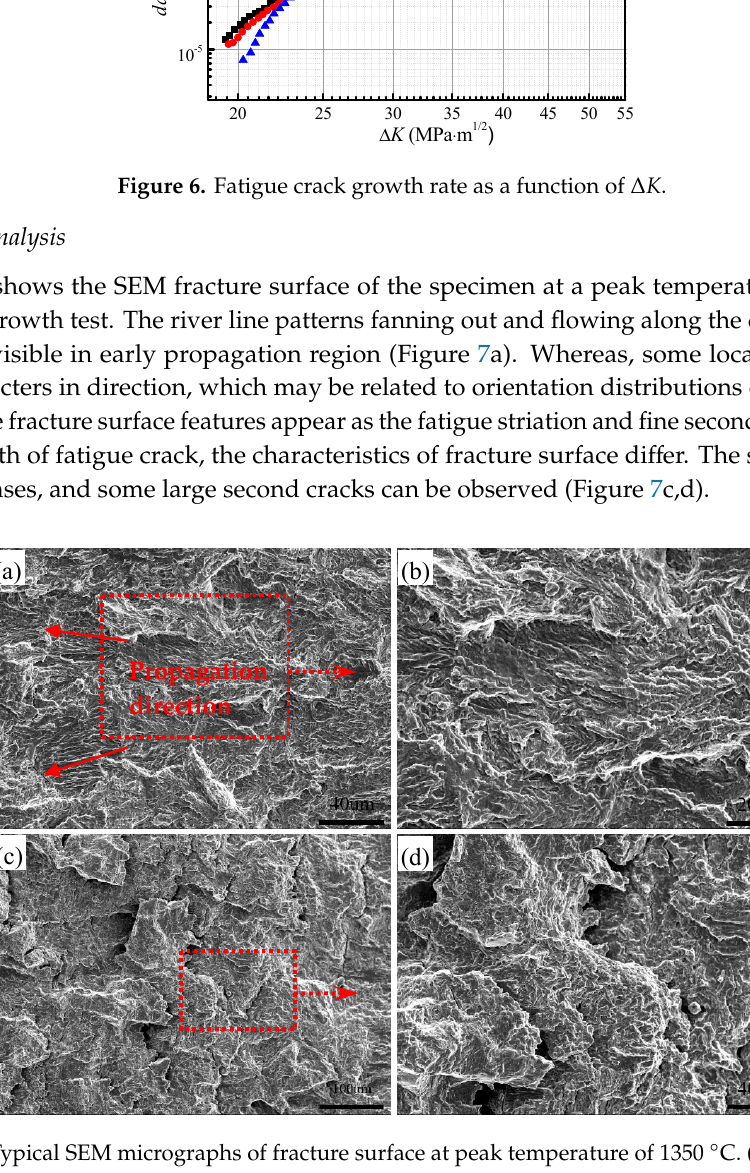
Figure 6. Fatigue crack growth rate as a function of ∆ K .